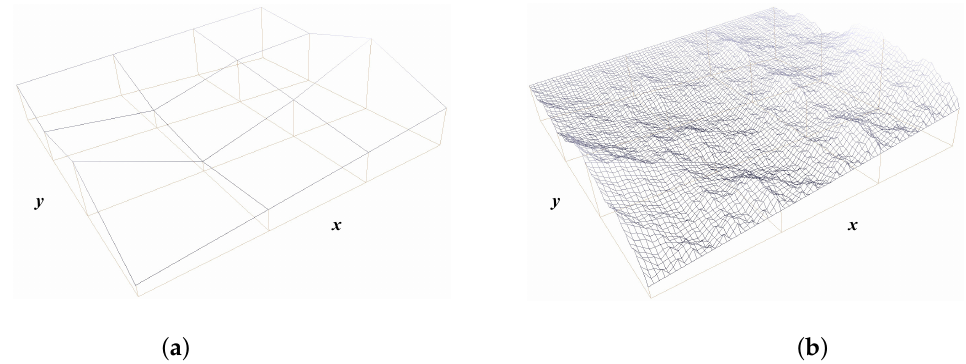
Figure 6. ( a ) The surface constructed with the original set of data. ( b ) The fractal interpolation surface.